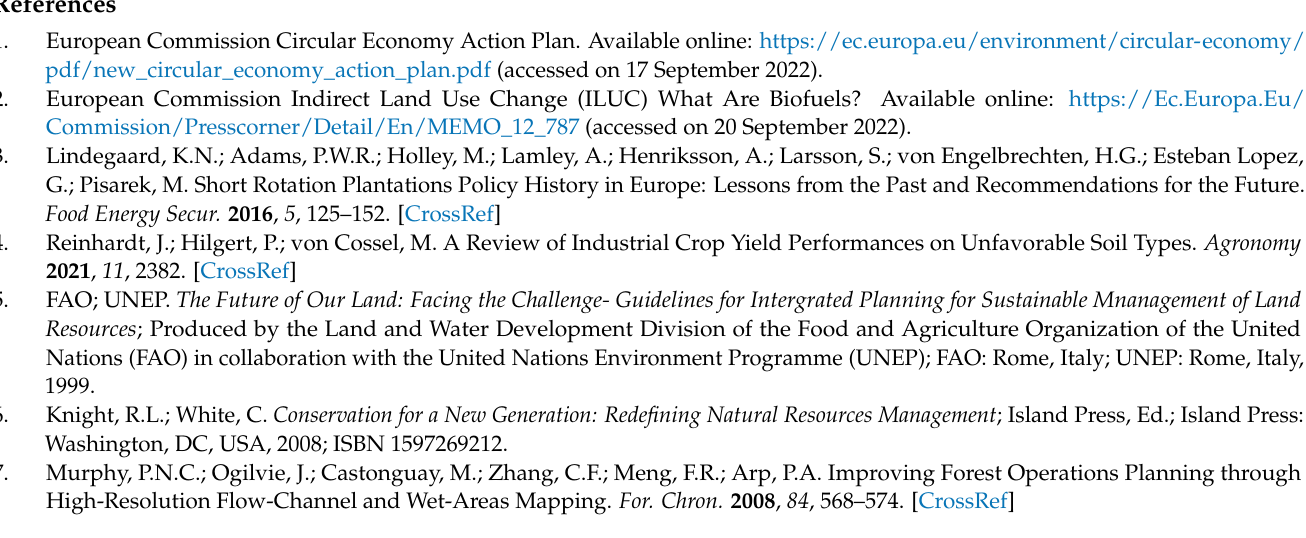
Road density map; Figure S3: Extraction distance map; Figure S4: Map of extracted timber amount; Figure S5: Terrain roughness map; Figure S6: Map of soil-bearing